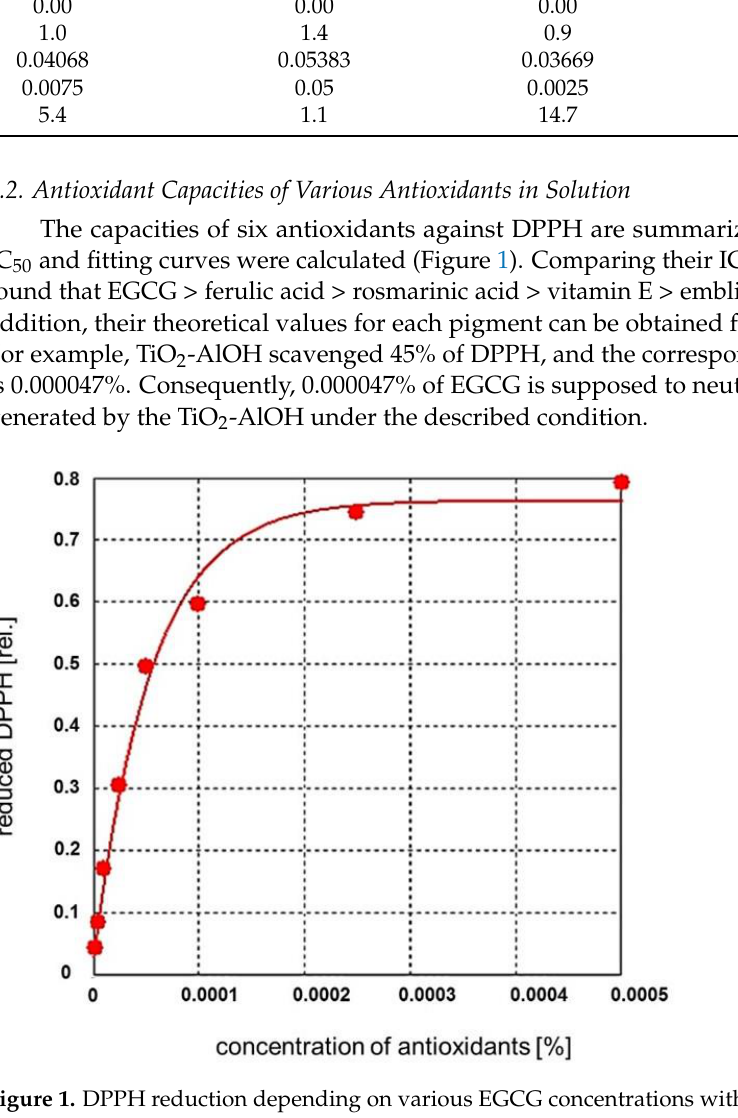
Figure 1. DPPH reduction depending on various EGCG concentrations with the best fit. The x-axis represents the concentration of antioxidants (in %); the y-axis represents the portion of DPPH reduced by oxidants, where 0 means no DPPH is reduced and 1 means all the DPPH molecules are reduced. Table 3. DPPH IC 50 values for the respective AO and its curve fittings including r 2 (EGCG = Epigal- locatechin Gallate, VE = Alpha-Tocoperol/Vitamin E, FA= Ferulic acid, SM= Sodium Metabisulfite).